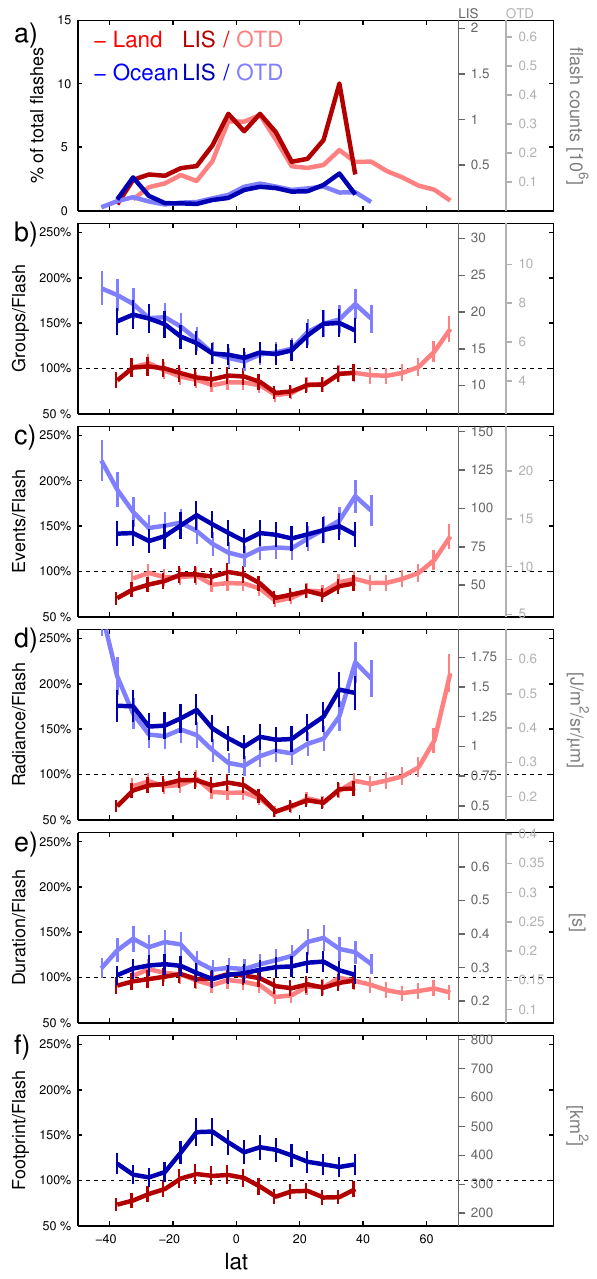
Figure 3. Latitudinal dependency of the mean flash properties for OTD (light) and LIS (dark), separately for land (red) and ocean (blue). All quantities are integrated in latitudinal bands of 5 ◦ width and normalized to the respective global sum of flash counts (a) or the global mean ( b – f ), respectively (see first rows in Tables 2 and 3), to make OTD and LIS comparable. The original scales for both OTD and LIS are shown in the additional axes on the right. Means with less than 5000 flashes in a latitudinal band are skipped. Footprint is not available for OTD. Error bars indicate the uncertainty of 10% due to the clustering algorithm (Mach et al., 2007), while statistical errors of the means are negligible due to the high sample size.